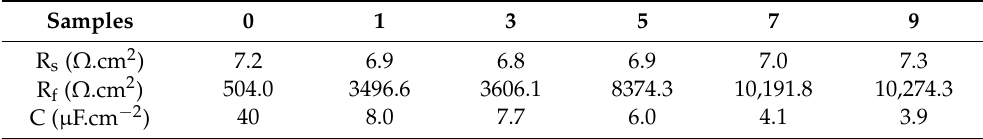
Figure 13. ( a ) Equivalent circuit pattern for etched 7075 aluminum alloy. Schematic diagrams of anticorrosion mechanisms for ( b ) bare aluminum alloy and ( c ) etched sample. Table 2. Fitted electrochemical parameters of modified 7075 aluminum alloys with various etching times